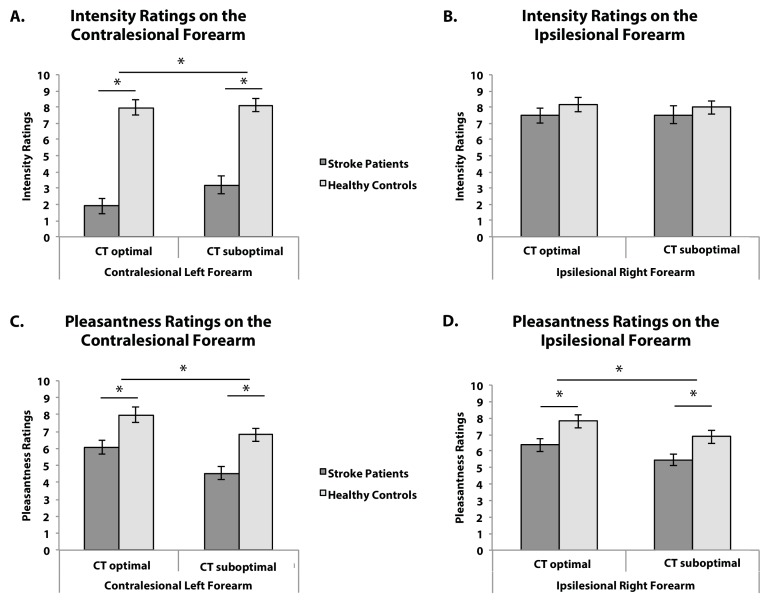
Behavioural Results.(A) Average intensity ratings on the contralesional left forearm (NRH = 39, NHC = 20), (B) Average intensity ratings on the ipsilesional right forearm (NRH = 20, NHC = 20), (C) Average pleasantness ratings on the contralesional left forearm (NRH = 35, NHC = 20), (D) Average pleasantness ratings on the ipsilesional right forearm (NRH = 41, NHC = 20), for CT-optimal and CT suboptimal touch. Stroke patients (RH) are depicted in dark gray, Healthy controls (HC) in light gray. Error bars represent the standard error of the mean. *depicts significant comparison, p<0.05.